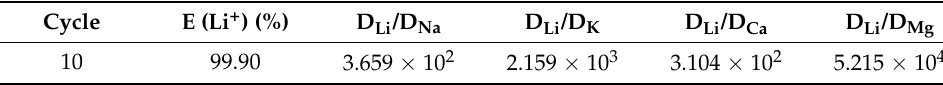
Table 5. The extraction percentage and separation factor.